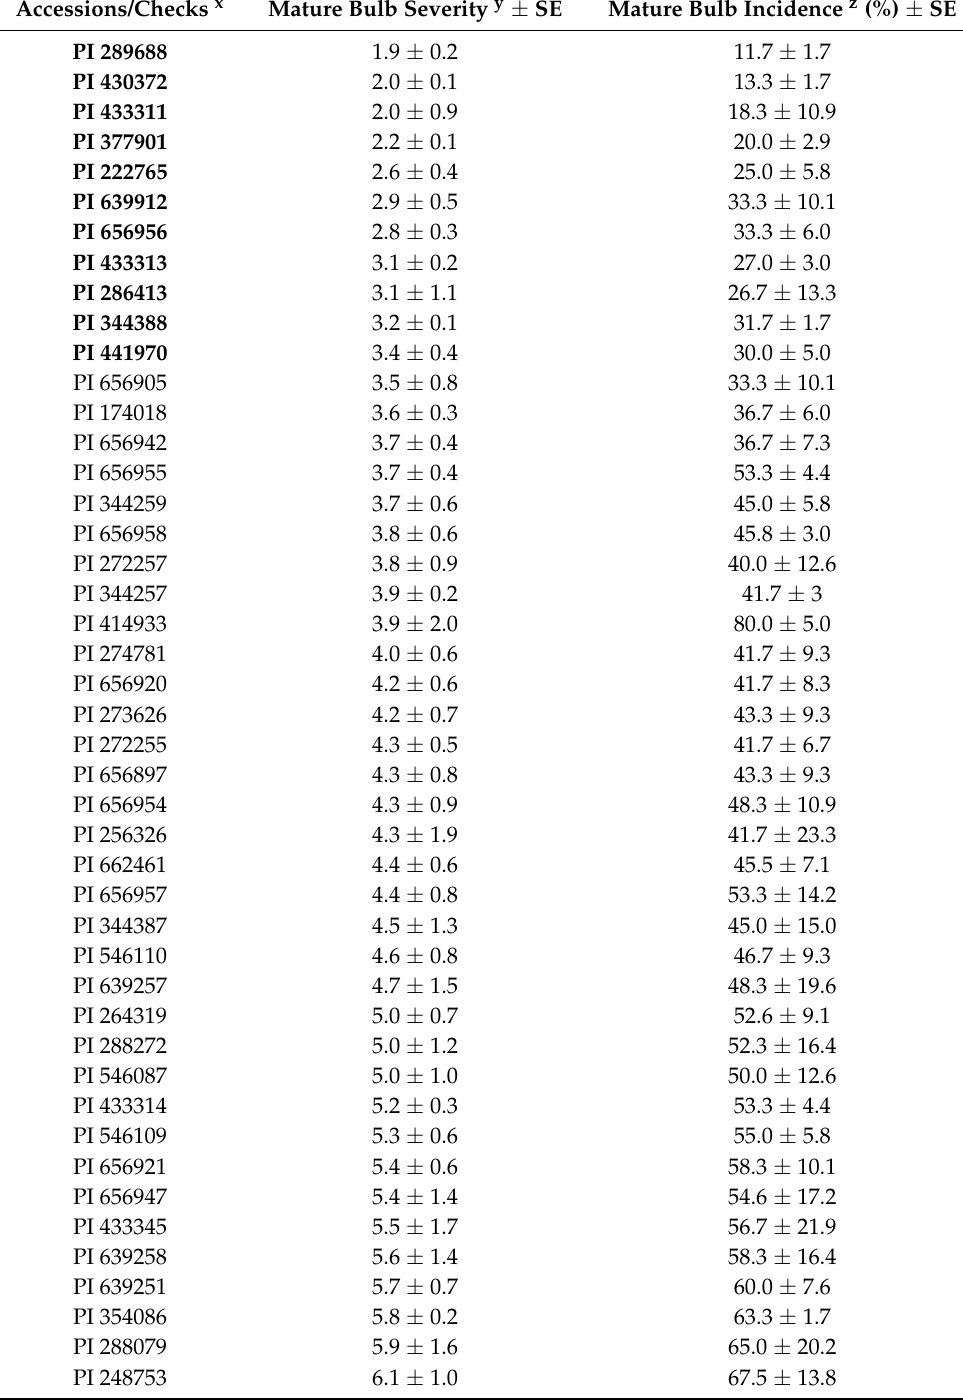
Table 3. Mean FBR severity (in ascending order) and incidence (%) of USDA onion PI accessions evaluated in the mature bulb stage after inoculation with Fusarium oxysporum f. sp. cepae